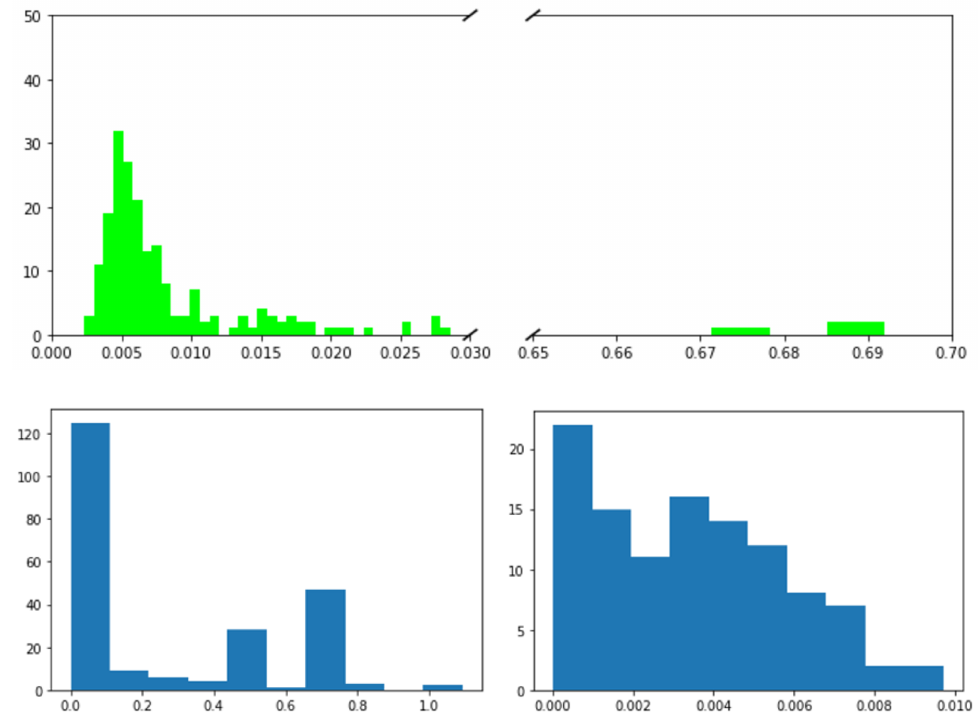
Figure 5 . Top : histogram plot generated by the maximum entropy of the principal axes of 225 random g s. There are a few outliers in the data, hence why we have used an interrupted x -axis. Notice how the majority (197 out of the 225) of the entries are present in the left subplot. Bottom left : we plot the maximum entropy of the principal axes of g in the 225 solutions for su (4) . Similar to the subplot on top left, we see a stronger presence on the left side, with the leftmost bin containing > 120 of the solutions. Bottom right : we zoom in on that leftmost bin, more precisely all entries below 0 . 01 , and observe a very different pattern from the top left subplot: there is a much stronger concentration of low entropies with 37 entries out of the total 225 below 2e-3. There is no entry below that value in the random